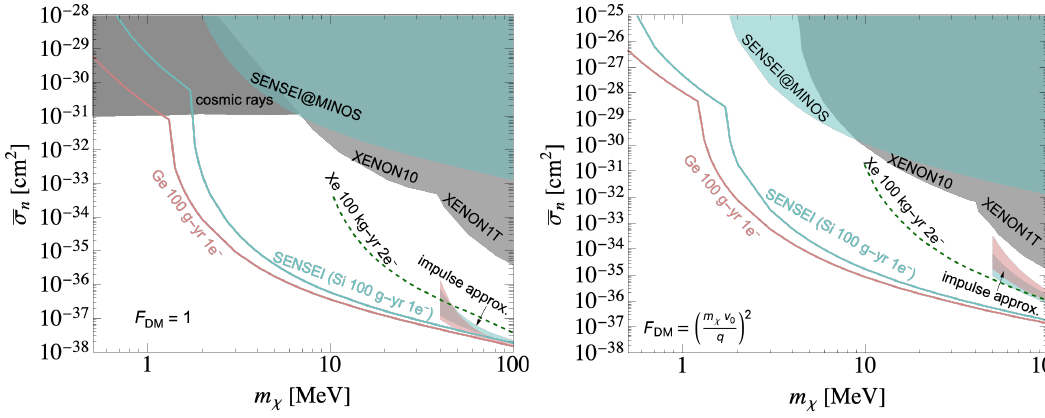
Figure 6. Projections using the Migdal effect of the 90% C.L. on the DM-nucleon cross-section for a heavy ( left panel ) and light ( right panel ) mediator for SENSEI (100-g-year silicon detector) ( cyan ) and a hypothetical 100-g-year germanium detector ( red ) with 1 e − 1 thresholds (see text for details). We find no difference in the total rate between using the exact dynamic structure factor (eq. (4.2)) and the one obtained in the free-ion approximation (eq. (4.7)) — see text for details. For comparison we show projections for “LBECA,” a proposed 100 kg-year xenon detector, with a 2 e − threshold ( green, dashed ) [17]. The shaded cyan and red regions correspond, respectively, to the result for silicon and germanium reported in [45], where the authors used the impulse approximation and imposed an IR cutoff on the momentum integral when the approximation breaks down. The un- p p certainty band corresponds to varying the cutoff from q min = 2 2 m N h E ph i to q min = 3 2 m N h E ph i . The gray-shaded regions correspond to current constraints from XENON10 [67], XENON1T [68], and a recast of XENON1T data for cosmic-ray up-scattered DM [69]. The cyan shaded region indicates our recast of the SENSEI@MINOS [20]